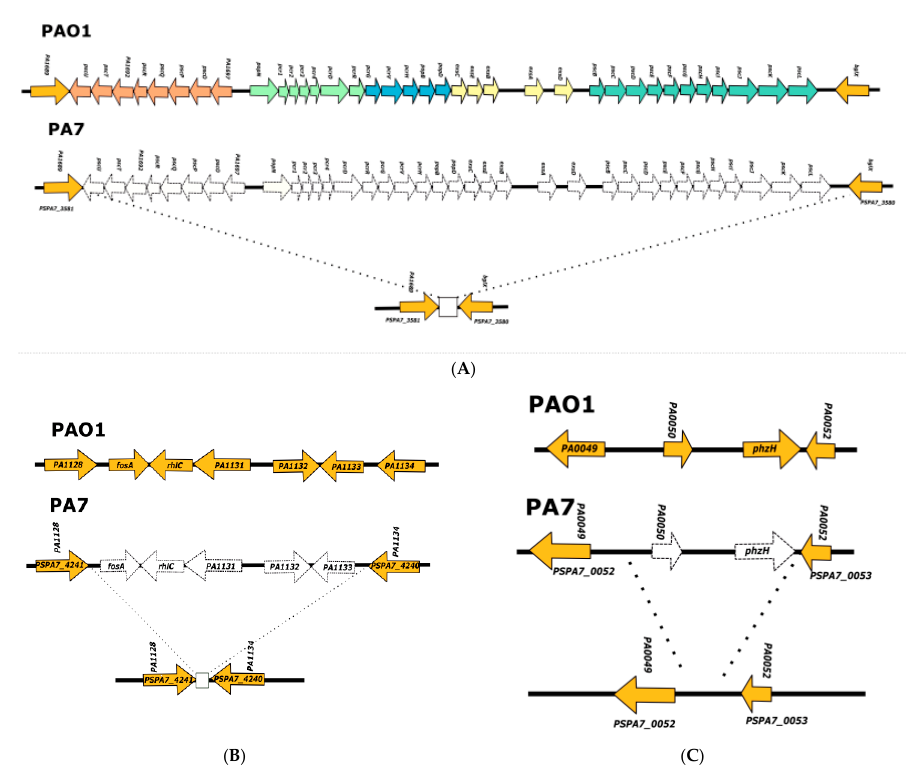
Figure 2. Analysis of PA7 genome regions where the genes involved in T3SS, rhlC, and phzH are encoded in the PAO1 strain. ( A ) Representation of the PAO1 and PA7 chromosomal regions, where genes involved in the T3SS are encoded in the former strain; the five operons encoding genes involved in the T3SS in the PAO1 chromosome are shown in different colors, and the lack of the 36 genes encoded in these operons in strain PA7 chromosome is shown with a dotted line; the square at the bottom of the figure represents the 56 bp sequence that is present in the 36 strains belonging to clade 3 detected in the PsGenDatab. ( B ) Representation of the PAO1 and PA7 chromosomal regions where rhlC is encoded in the former strain; the homologous genes are shown in orange, and the genes that are absent in the PA7 chromosome are shown with a dotted line; the square shown at the bottom of the figure corresponds to the 93 bp sequence that is present in the 36 strains belonging to clade 3 detected in the PsGenDatab. ( C ) Representation of the PAO1 and PA7 chromosomal regions where phzH is encoded in the former strain; homologous genes are shown in orange and genes that are absent in the PA7 chromosome are shown with dotted